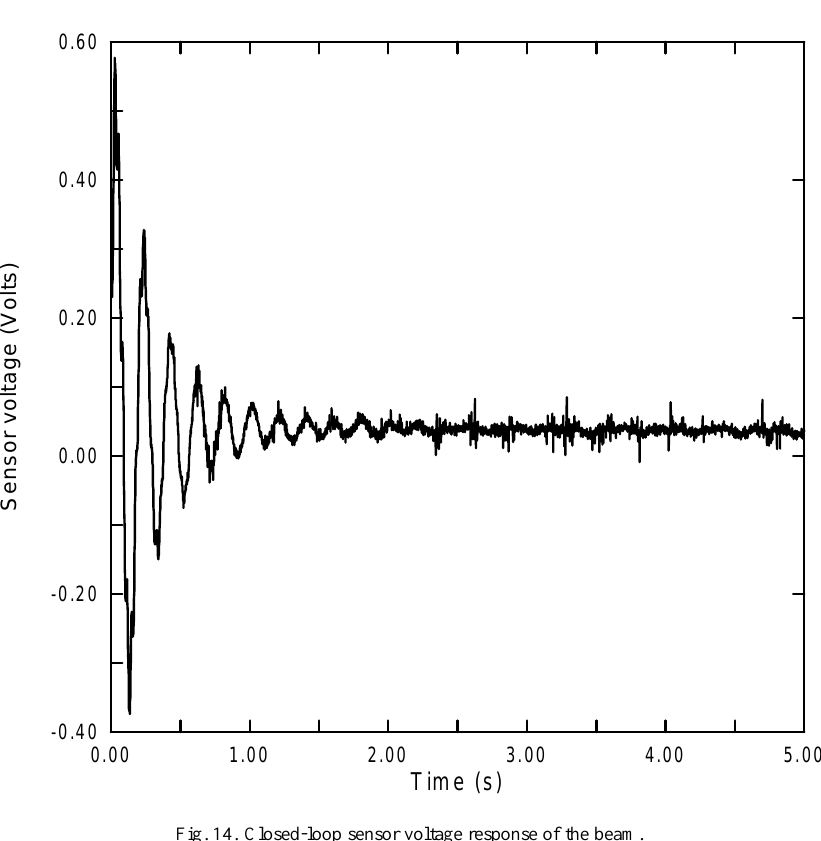
Fig. 14. Closed-loop sensor voltage response of the